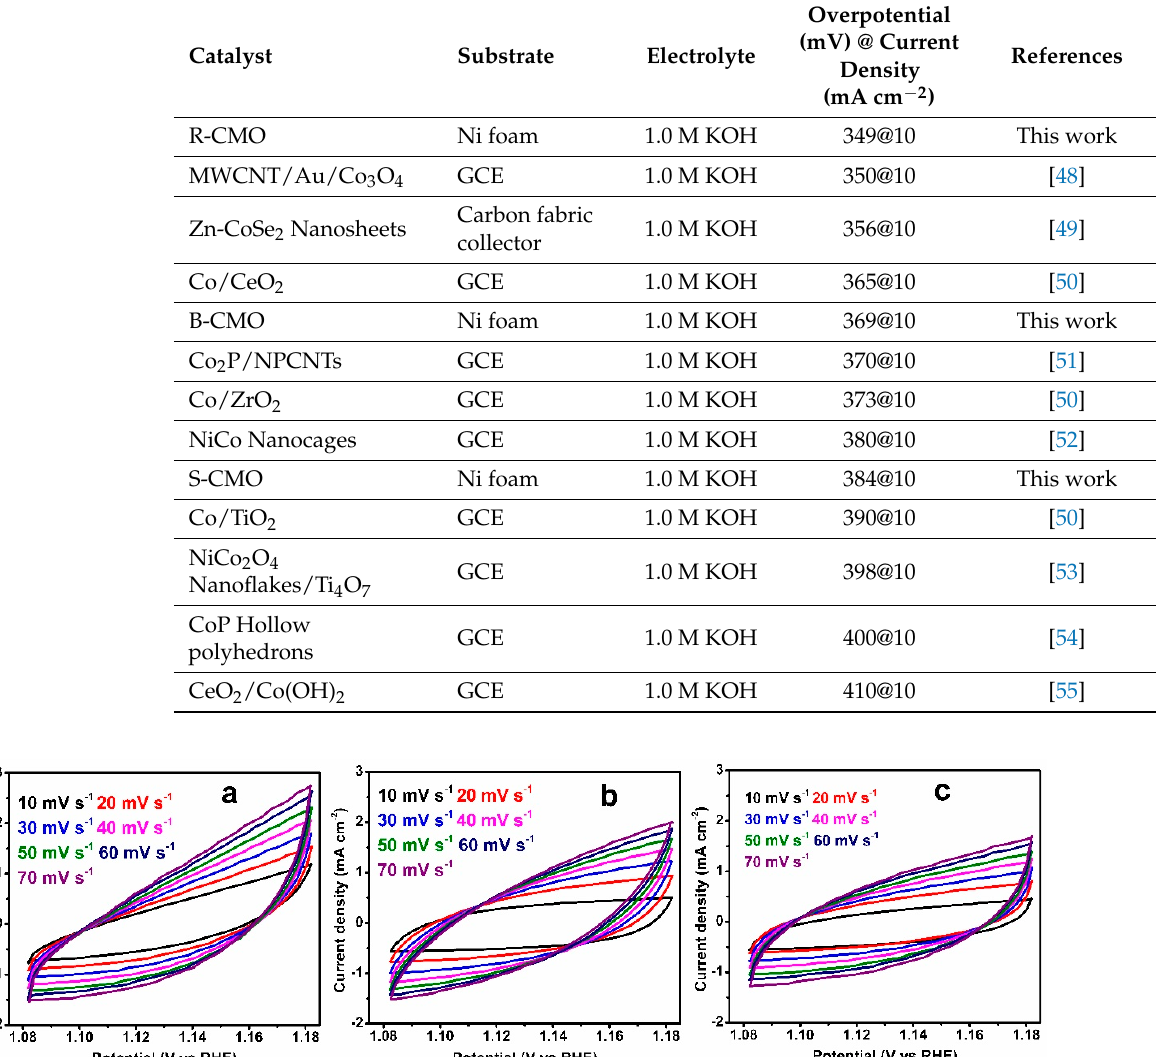
Figure 6. ECSA curves of ( a ) R-CMO, ( b ) B-CMO and ( c ) S-CMO catalysts.